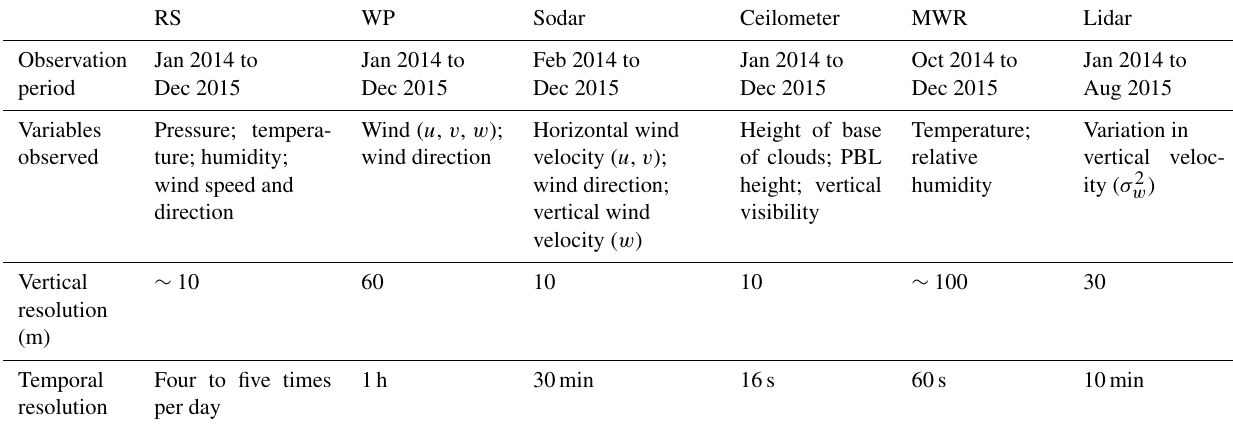
Table 1. This table presents a synthesis of the instruments used in this study, the observation periods, and temporal and spatial resolutions. RS WP Sodar Ceilometer MWR